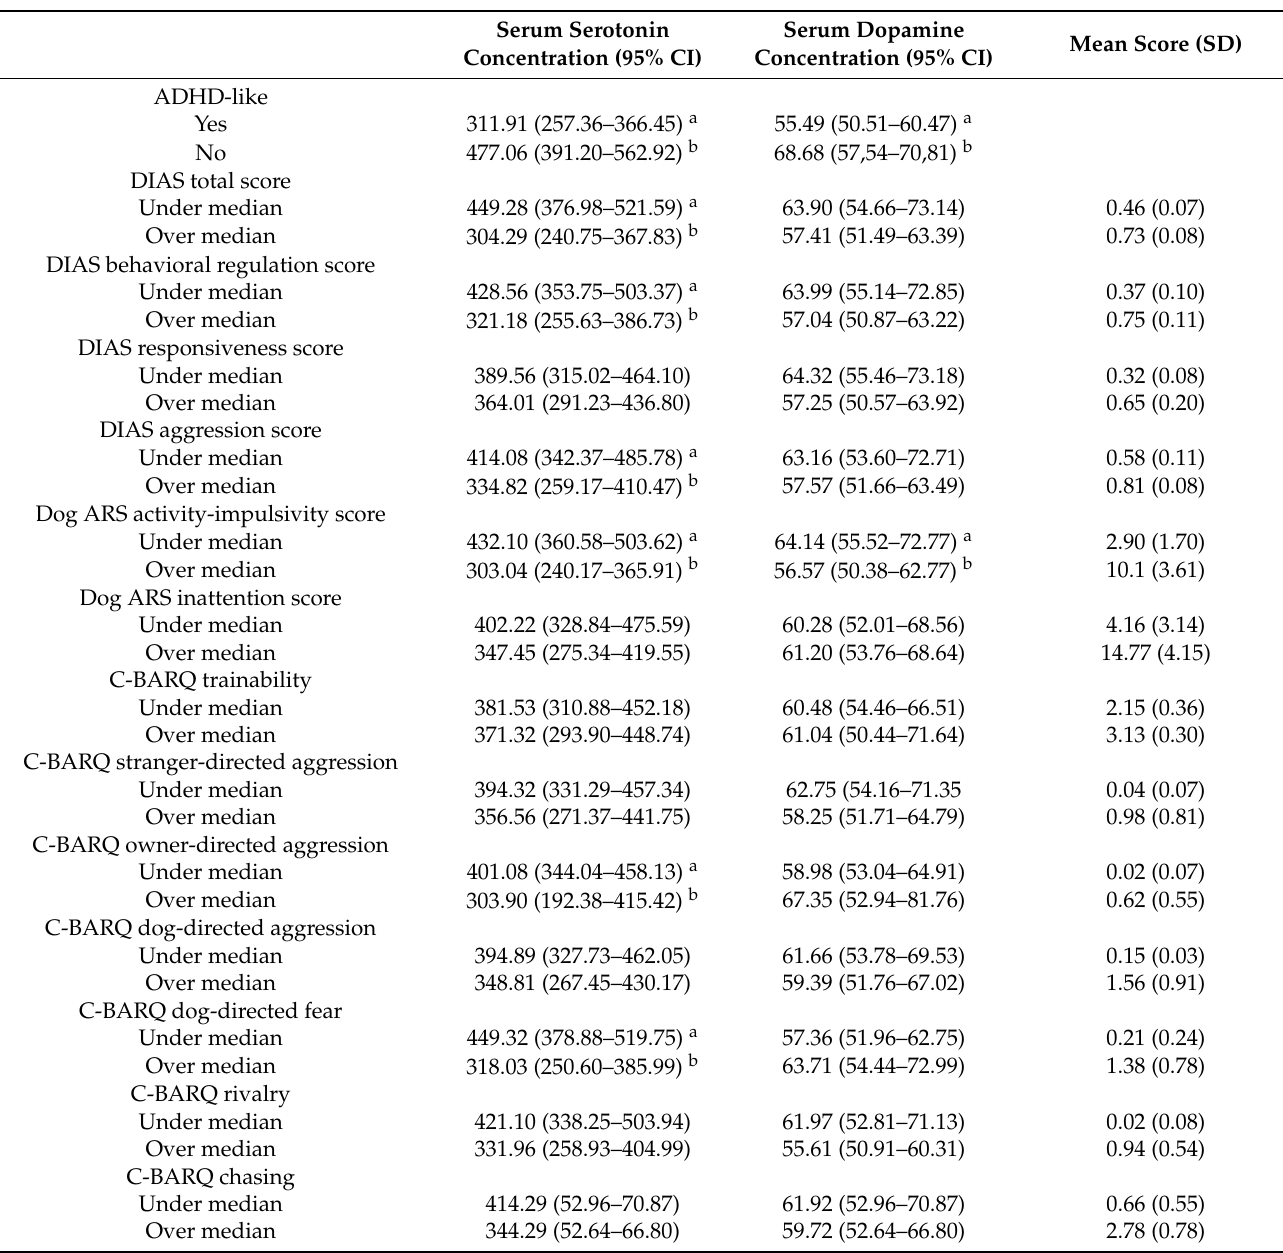
Table 3. Mean serotonin and dopamine serum concentrations (ng/mL) of the dogs with suspected diagnoses for being ADHD-like (vs. the not ADHD-like dogs) and the dogs with scores over and under the median for the different DIAS, DOG ARS, and C-BARQ traits (different superscripts indicate significant differences). The mean scores obtained for the dogs with scores over and under the median for the different traits are provided, along with the standard deviations